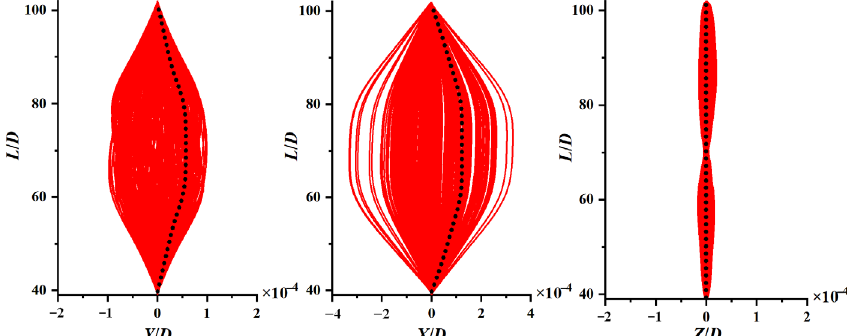
Figure 12. The time-varying response profiles (solid lines) and associated RMS displacement profiles (dashed lines) along the three directions in the case of Q G